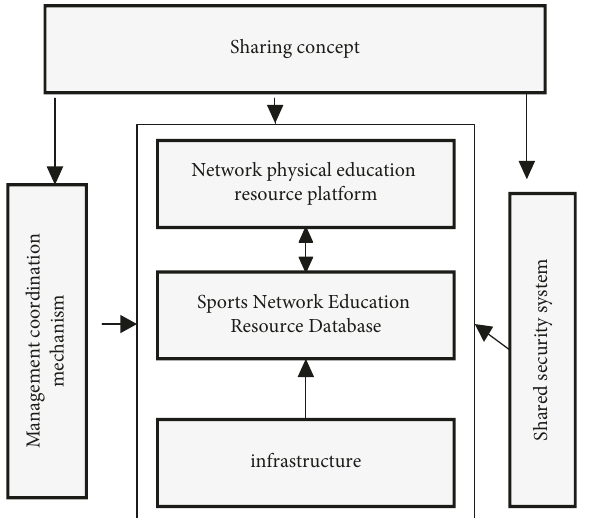
Figure 2: Framework of regional Korakan sports network edu- cation resource sharing